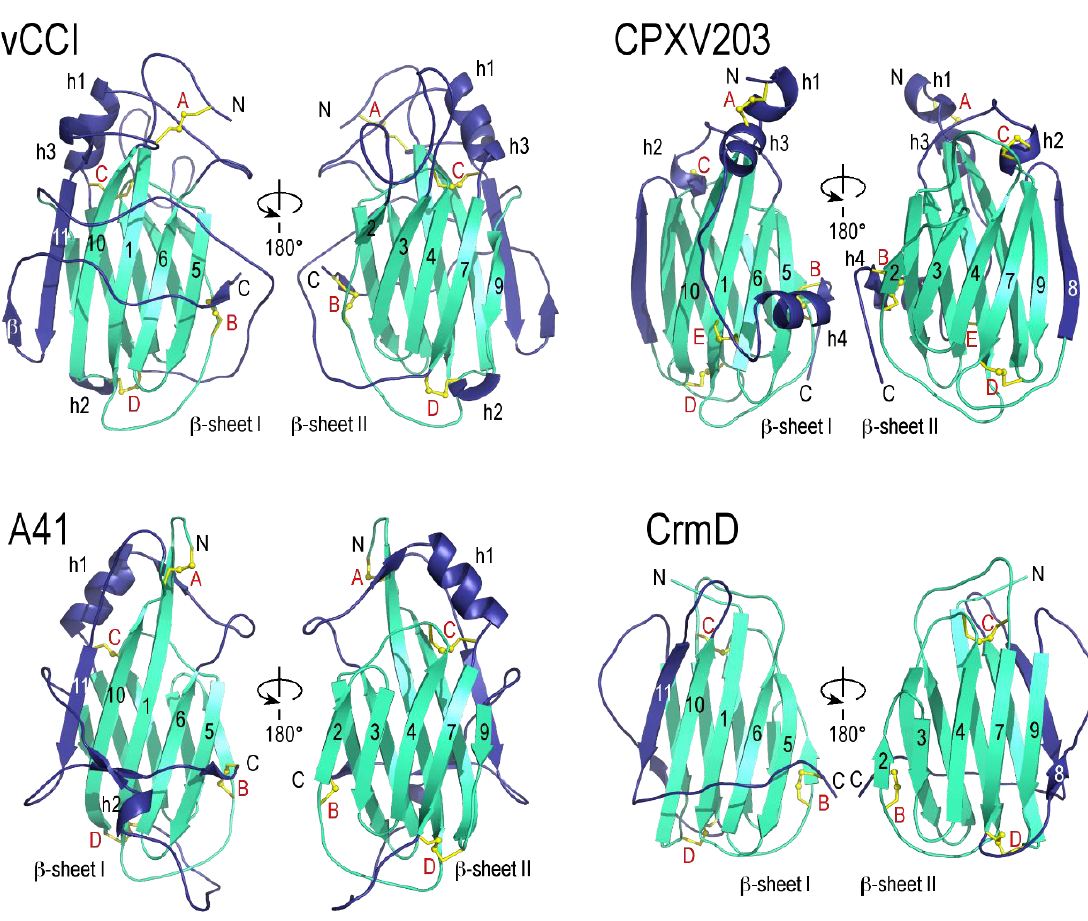
Figure 1. The poxvirus immune evasion (PIE) domain structures adopt a strikingly similar fold despite considerable sequence diversity. Strands in the β -sandwich core domain (cyan) are numbered the same for all four structures to aid comparison. The decorations unique to each structure (dark blue) are labeled (h for helix, β for strand). CPXV203 does not contain a strand β 11 in sheet I. Similarly, strand β 8 of sheet II is absent from vCCI and A41. The disulfide bonds are labeled in red ( A – E ). All ribbon diagrams are shown in the same orientation and at the same scale. Structures displayed include: rabbitpox vCCI (2FFK) [20], cowpox CPXV203 (4HKJ) [28], vaccinia A41(2VGA) [22], and ectromelia CrmD